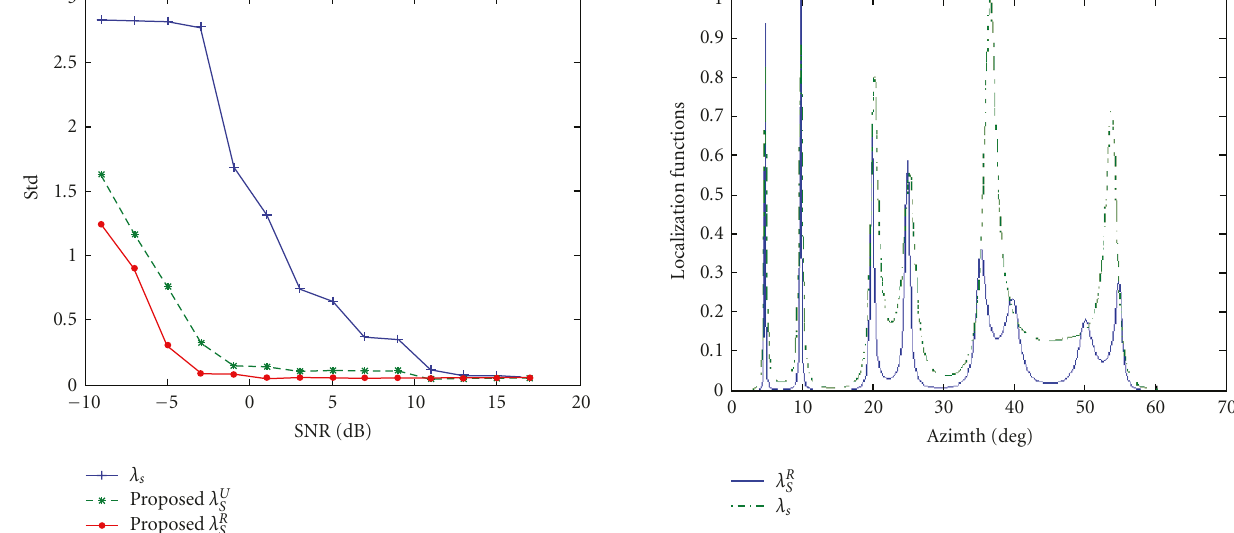
Figure 7: std of estimation errors as functions of SNR when the spectra of EG algorithm is used with m = 10.